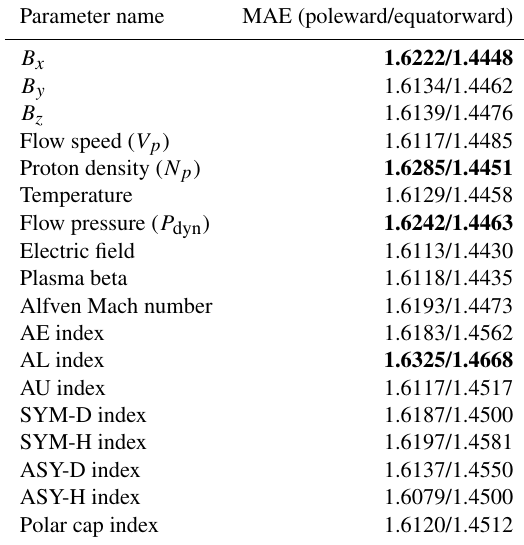
Table 3. The MAE influenced by different space physical parame- ters. The bigger MAE values in both the poleward and equatorward boundaries were written in bold font compared with others. The val- ues written in bold font representing its corresponding space phys- ical parameters had more influence on poleward and equatorward